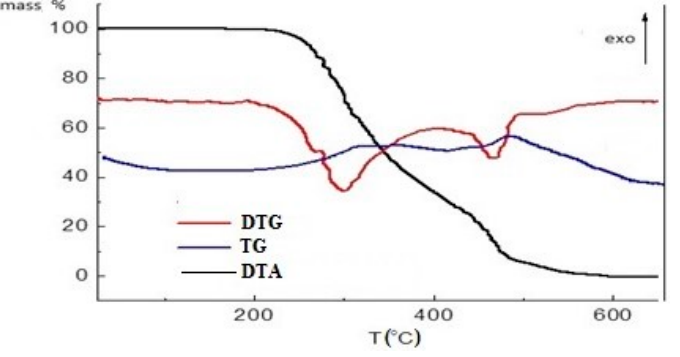
Figure 3. Thermogravimetric analysis (TGA) data for fluoropolyurethane 7 .